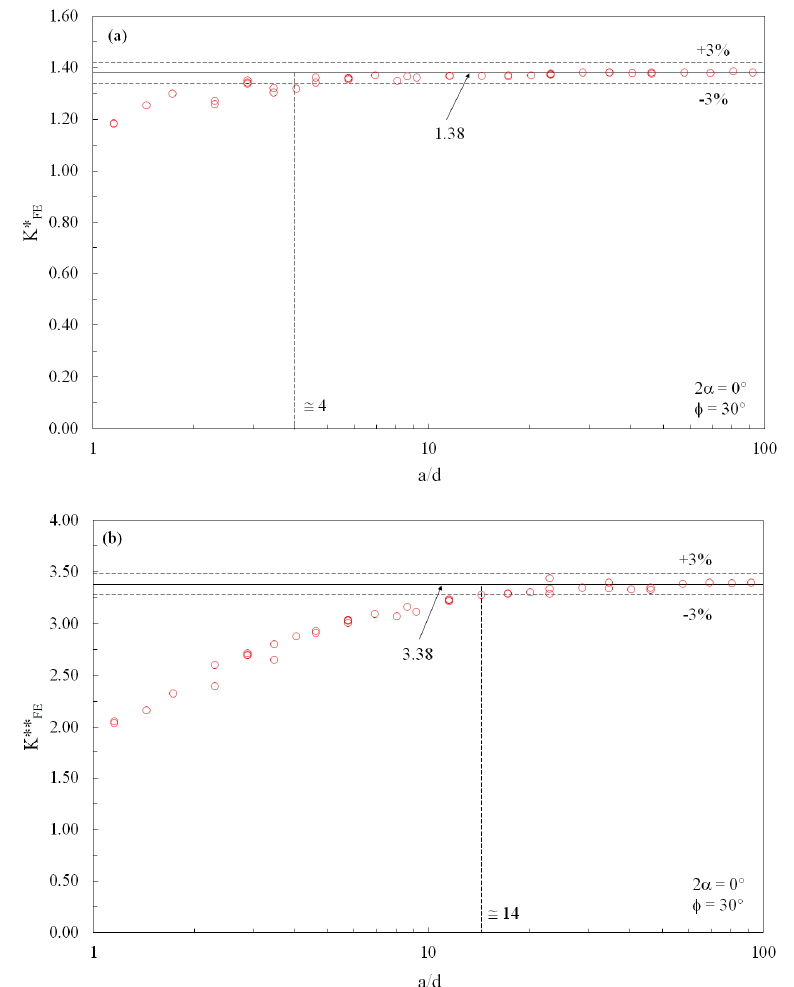
Figure 3: Calibration of the PSM approach for a crack (2 α = 0°) under mixed mode (I+II) loading ( ϕ = 30°). Normalized SIF related to (a) mode I and (b) mode